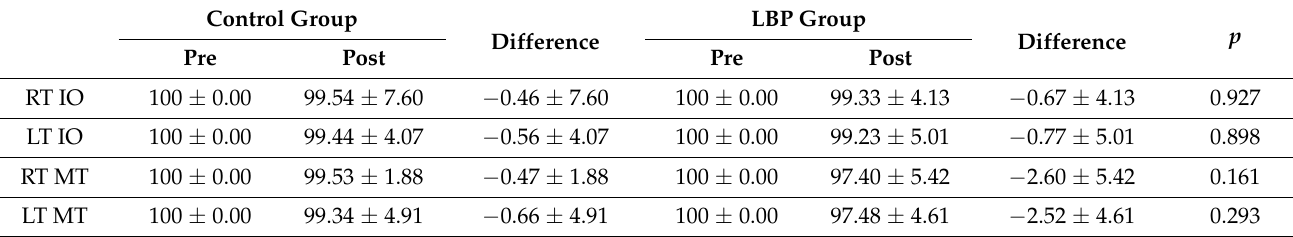
Table 2. Median frequency of the subject before and after 30 min of